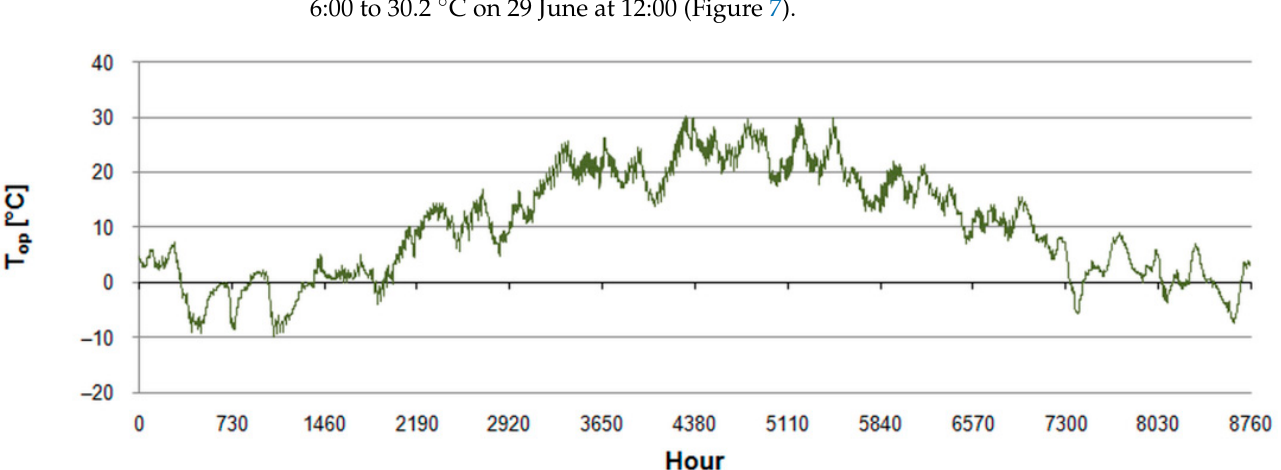
Figure 8. Comfort zone of EN 15251 and daily operative temperature in analyzed months. A similar situation was observed when applying ASHRAE model (Equation (14)) with relevant margins). This time T op was within 80% of the acceptability range during 72 days. From them 20, 24, 18 and 10 days were in the same months, as previously. It should be noted here that use of global solar irradiance data on tilted surfaces from Polish typical meteorological year for Kielce resulted in significantly less convenient indoor conditions. Indoor operative temperature was within the considered acceptability range for 67 days (with 22, 17, 18, and 10 days in the same months) and 65 days (with 22, 9, 16, and 18 days) for EN 15251 and ASHRAE models, respectively. Higher values of solar irradiance in Polish TMY in comparison to the model of Perez [78] resulted in greater solar gains and higher indoor temperature. Therefore, use of proper meteorolog- ical data is essential when considering not only the energy performance of buildings [82], but also indoor comfort issues. When increasing the ventilation airflow rate twice to 180 m 3 /h, the number of “comfort” days decreased to 46 in total, with 12, 24, 10, and 0 days; and 70 in total, with 18, 26, 19, and 7 days in the same months for EN and ASHRAE requirements, respec- tively. In case of Polish TMY, 64 days (18, 23, 16, and 7) and 73 days (23, 21, 19, and 10